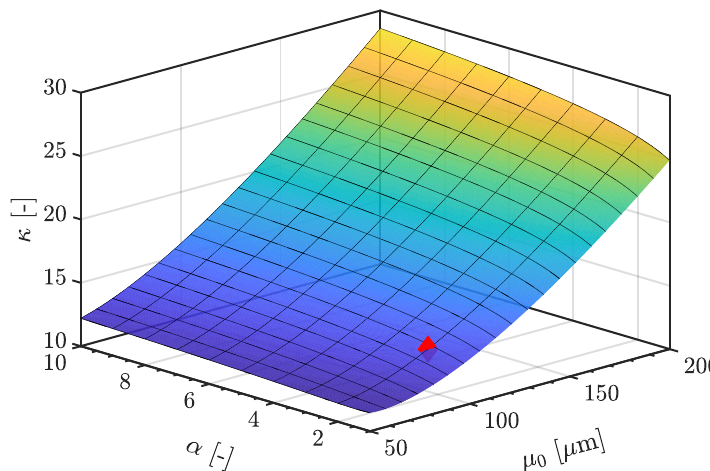
Figure 13. Weibull factor κ depending on the return period α and the defect population µ 0 and evaluated point of the current test series of specimen B.